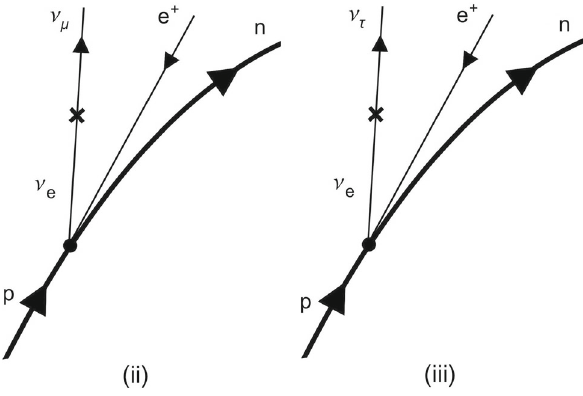
Fig. 2 Inverse β -decayinthelaboratoryframeinthepresenceofflavor oscillations (time flows in the vertical direction). The crosses denote the occurrence of the oscillation